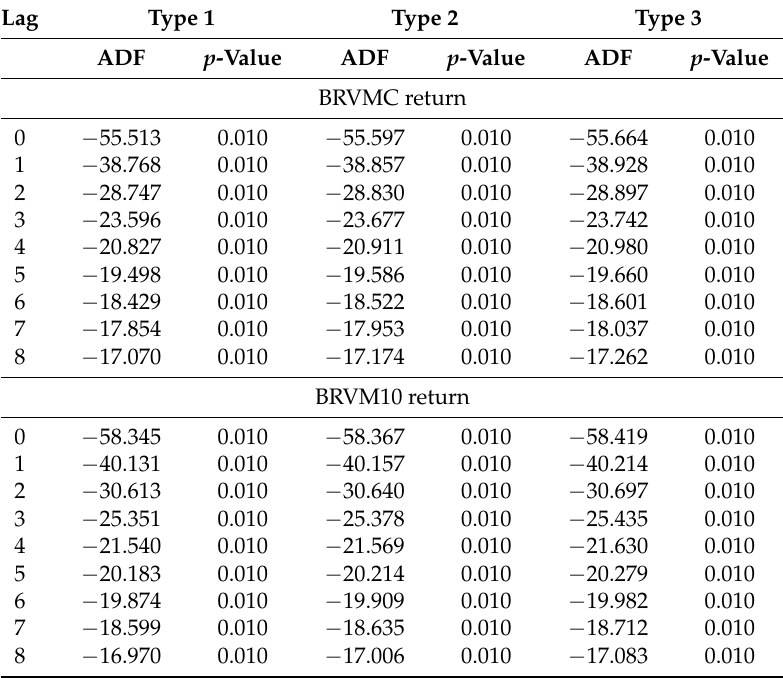
Table A2. Unit root tests (ADF) on the return